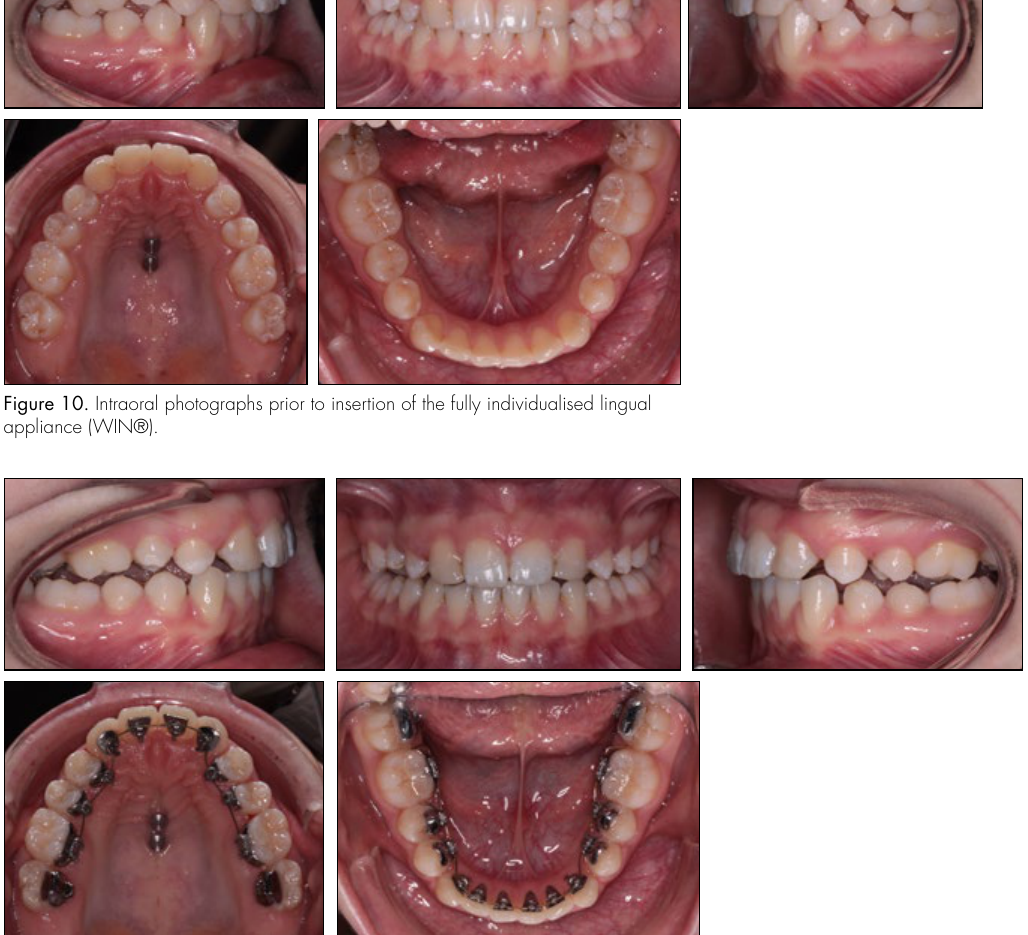
Figure 11. Intraoral photographs following insertion of the fully individualised lingual appliance (WIN®).